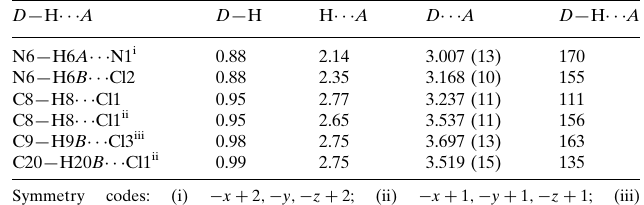
Hydrogen-bond geometry (A˚ , (cid:2)